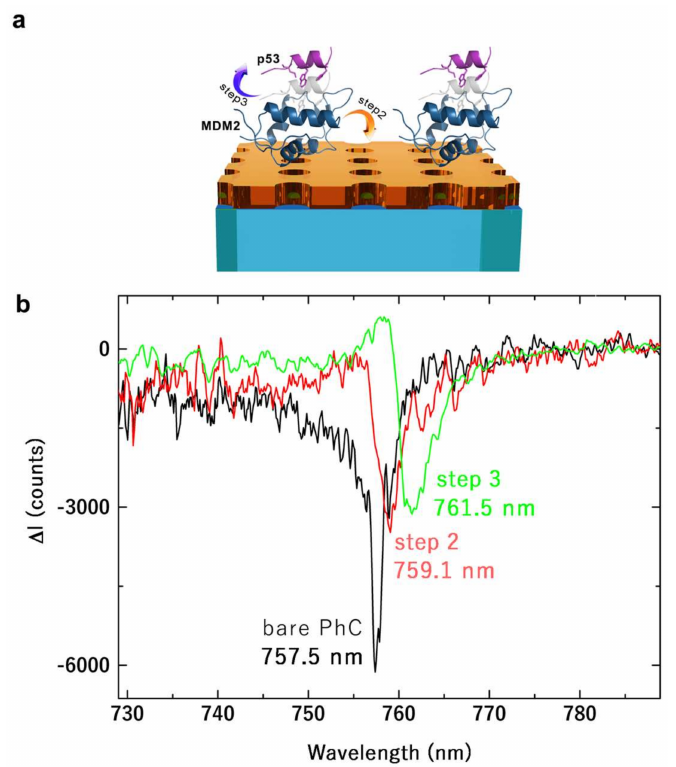
Figure 6. ( a ) Schematic layout of the two-dimensional square PhC with the MDM2 protein (step 2) dispersed over the whole sample surface and the subsequent interaction with p53 protein (step 3). ( b ) Measured transmitted spectra collected from the sensor device corresponding to the bare PhC (black curve), after the MDM2 deposition (red curve), after the interaction with p53 (green curve). Negative values of the intensity are due to background subtraction.